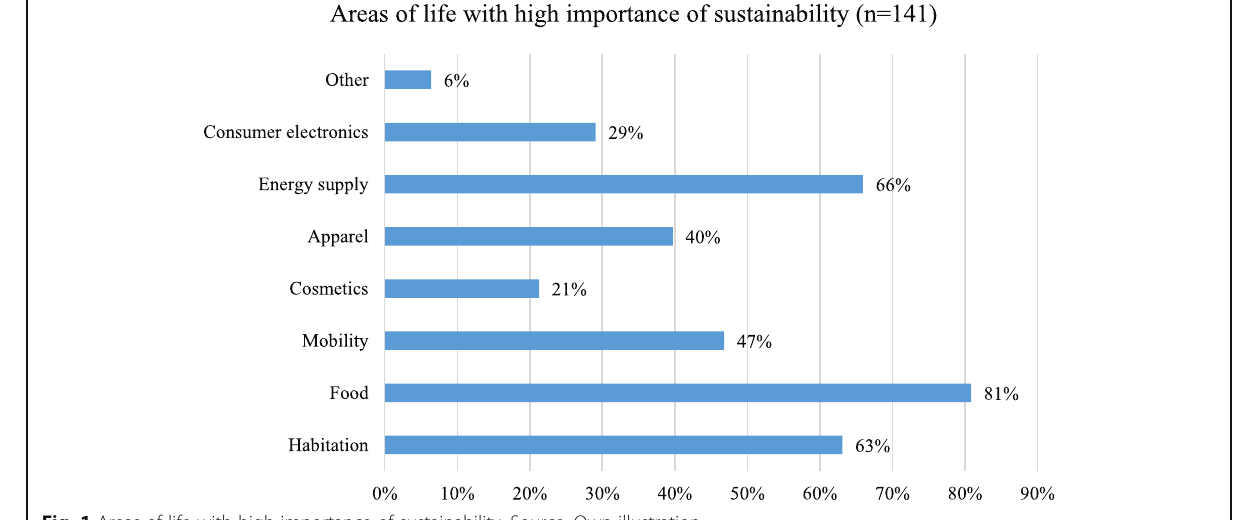
Fig. 1 Areas of life with high importance of sustainability. Source: Own illustration